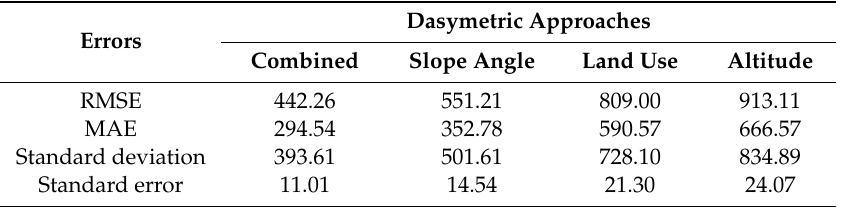
Table 3. RMSE summary statistics for di ff erent dasymetric